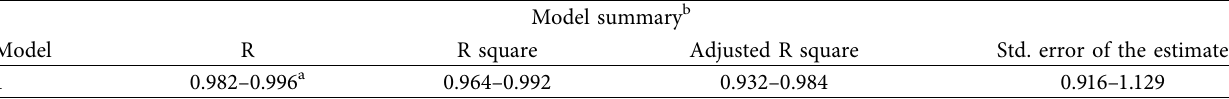
Table 4: Model summary of the entire analysis showing adjusted R square and standard error values.